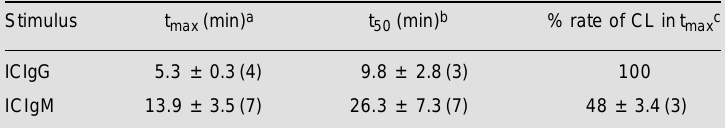
Table 1 - Chemiluminescence produced by polymorphonuclear leucocytes stimulated with ICIgM and ICIgG. a Time interval from the incubation of PMN and immune complexes (zero time) to the time of the maximum rate of CL emission. b Time interval from zero time to the time when the CL rate had decayed to 50% of the maximum. c Comparison of the maximum rates of CL, produced by ICIgG and ICIgM, taking 100 as the value for the CL induced by ICIgG and expressing the CL produced by ICIgM as the percentage in each paired experiment. Results are reported as means ± SD for the number within parentheses of independent experiments (different cell populations). Concentration of both classes of immune complexes: 200